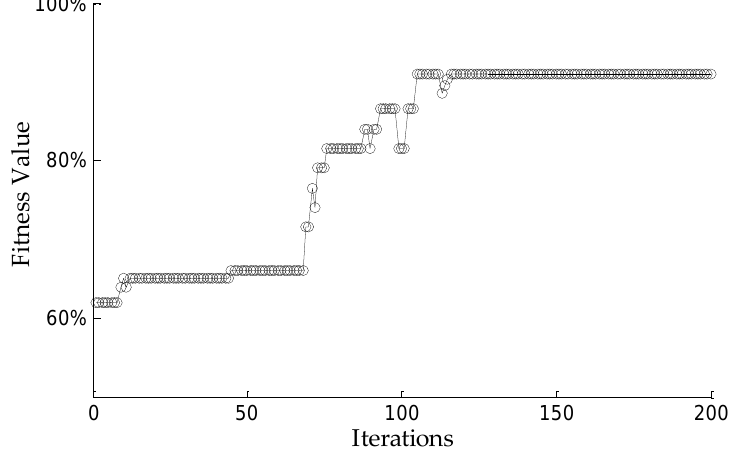
Figure 11. Fitness value curve. The selection of kernel parameters: δ1=1.181, δ2=0.123 and δ3=0.125.